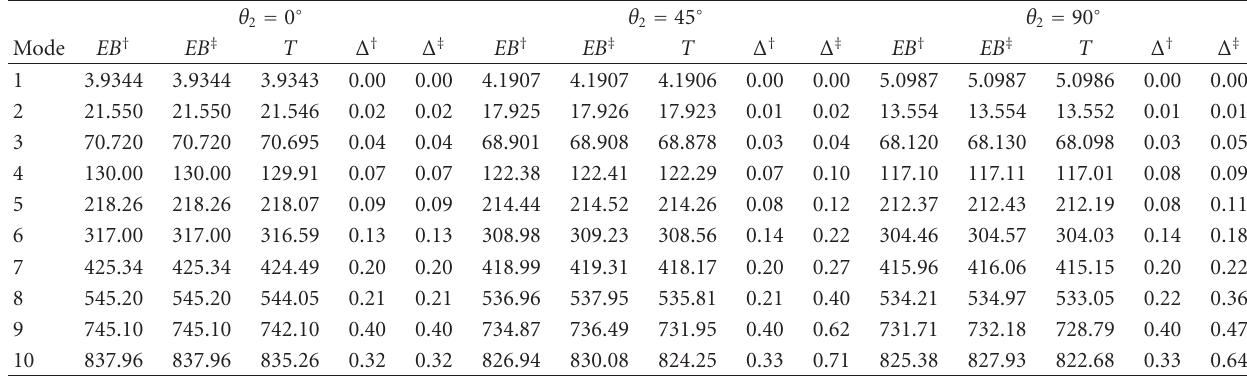
Table 3: First ten natural frequencies (Hz); two-link manipulator; ( L 1 /h = 83 . 33, L T /h = 173 .